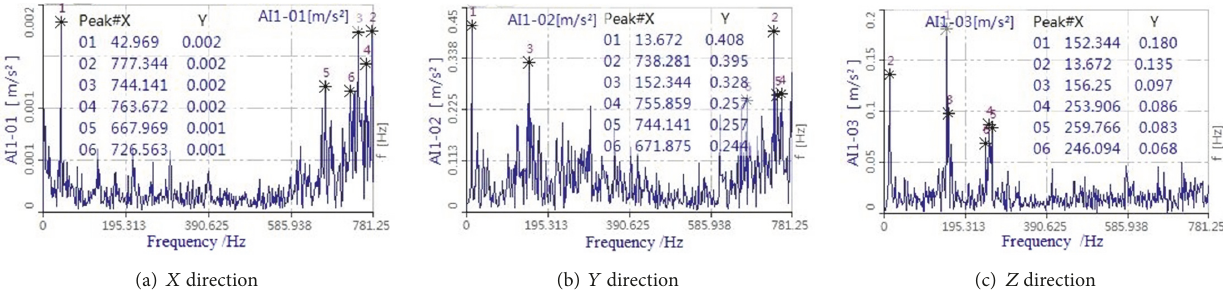
Figure 12: Frequency domain vibration signal of no-load cylinder rotation.